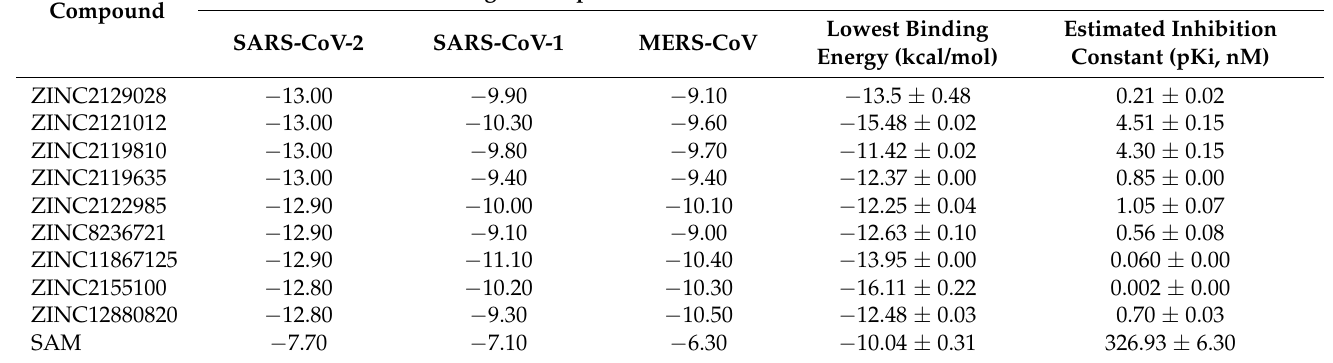
Table 1. Lowest binding energy of the selected 9 candidates and the control drug SAM upon screening against SARS-CoV-2, SARS-CoV-2, and MERS-CoV. The table also shows the molecular docking